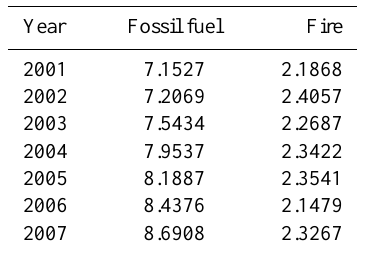
Table 1. Annual fossil fuel and fire emissions across 2001–2007 (in PgCyr − 1